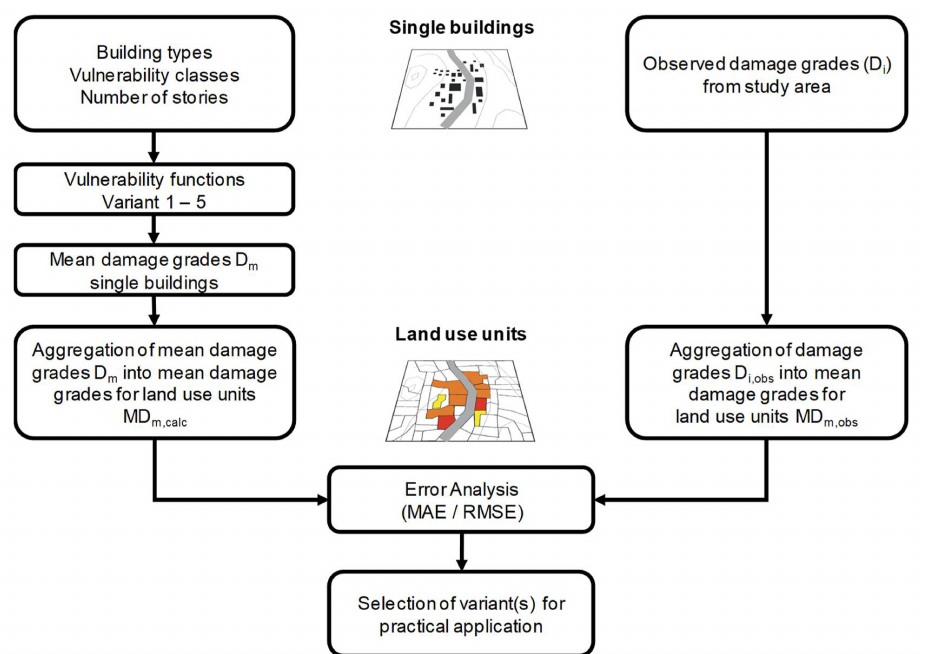
Figure 11. Flow chart of numerical validation.